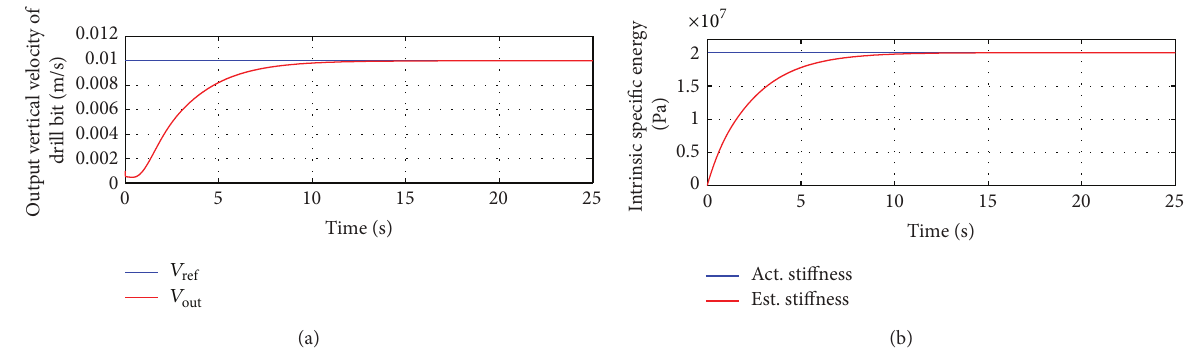
Figure 7: Response of the vertical velocity V (𝑡) (a) and the intrinsic specific energy estimate ̂𝜖(𝑡) (b) for 𝑊 0 = 2500 N, 𝜖 = 20 MPa, and = 5 ⋅ 10 9 . 𝛾 0